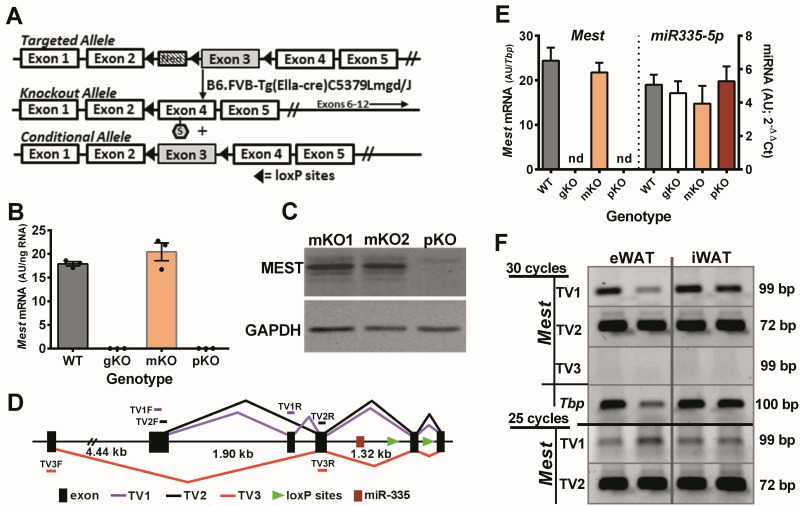
Validation of targeted Mest allele.(A) Representation of the targeted allele for mesoderm specific transcript (Mest) with loxP sites flanking Mest exon 3 and a Neo cassette located in intron 2. Deletion of Mest exon 3 causes a frameshift mutation and the generation of a stop codon (indicated with a hexagon containing an ‘S’) in Mest exon 4. (B) Analyses of Mest mRNA in adipose tissue of wildtype (WT; n = 3) mice and mice with homozygous (gKO; n = 3), maternal (mKO; n = 3) and paternal (pKO; n = 3) allelic inactivation of Mest by qRT-PCR showed complete loss of mRNA in adipose tissue of Mest gKO and pKO mice. (C) Western blot analysis shows MEST protein in adipose tissue of 2 mice with maternal allele inactivation of Mest (mKO1 and mKO2) whereas MEST protein is completely absent in adipose tissue of mice with a paternal allele inactivation of Mest (pKO). (D) Representation of the Mest gene showing location of miR-335 near the proximal loxP site of the targeted Mest allele and 3 known splice variants (TV1, TV2 and TV3) for murine Mest. Small bars located above and below the diagram indicate the approximate location of forward reverse primers used to measure relative levels of each variant in adipose tissue. (E) QRT-PCR analyses of Mest and miR-335 expression in total RNA isolated from 4–7 iWAT depots for each of 4 genotypes of 6–7 day old mice indicates that deletion of Mest exon 3 has minimal effect on miR-335 expression. Levels of Mest and miR-335 expression are presented as the mean ± SEM. (F) RT-PCR analyses for 30 and 25 cycles indicates that transcript variant 2 (TV2; NM_008590.2) is the predominant Mest isoform in both epididymal white adipose tissue (eWAT) and inguinal white adipose tissue (iWAT). Sizes of PCR products for each of the transcript variants and TATA-box binding protein (Tbp) are shown on the right hand side of the figure.